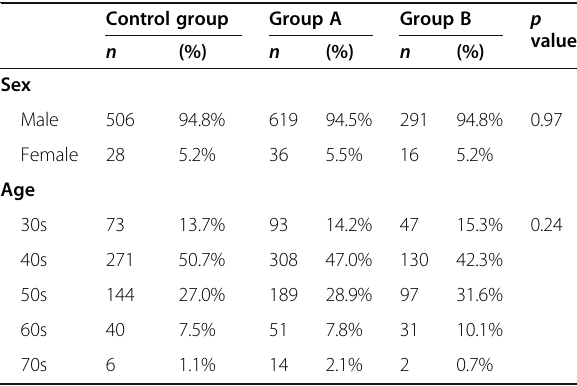
Table 1 The baseline characteristics of the participants in the general health